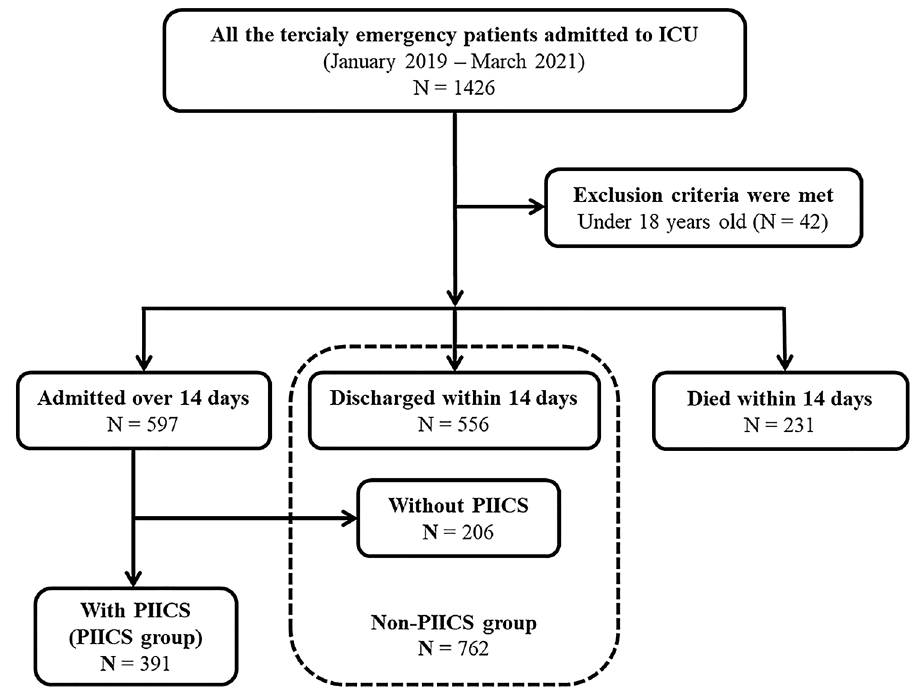
Figure 1. Chart showing the patient selection process. PIICS persistent inflammation, immunosuppression, and catabolism